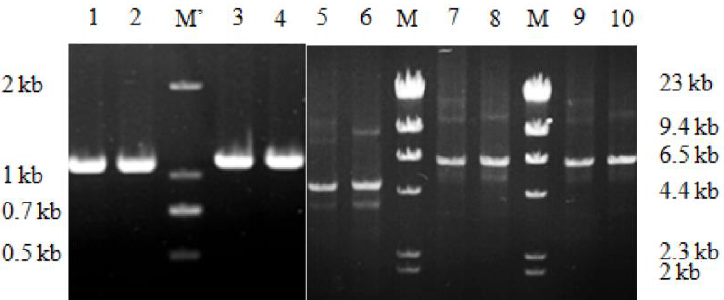
Figure 2. Gel electrophoresis of the amplified megaprimers and the plasmid DNAs. DL2000 DNA ladder (M’) and HindIII-digested λ-DNA (M) used as marker. The intra-HR-for megaprimer AdD (L3-4) and the two-step PCR-for megaprimer AdD ’ (L1-2) were both at the expected 1.1 kb bands. The intra-HR-for plasmid DNAs were at the expected 4.8 kb for pET20b- AdD (L6), 6.5 kb for pET21a- AdD (L7-8), and 6.5 kb for pET22b- AdD (L9-10). The two-step PCR-for plasmid DNAs were at the expected 4.8 kb for pET20b- AdD (L5).